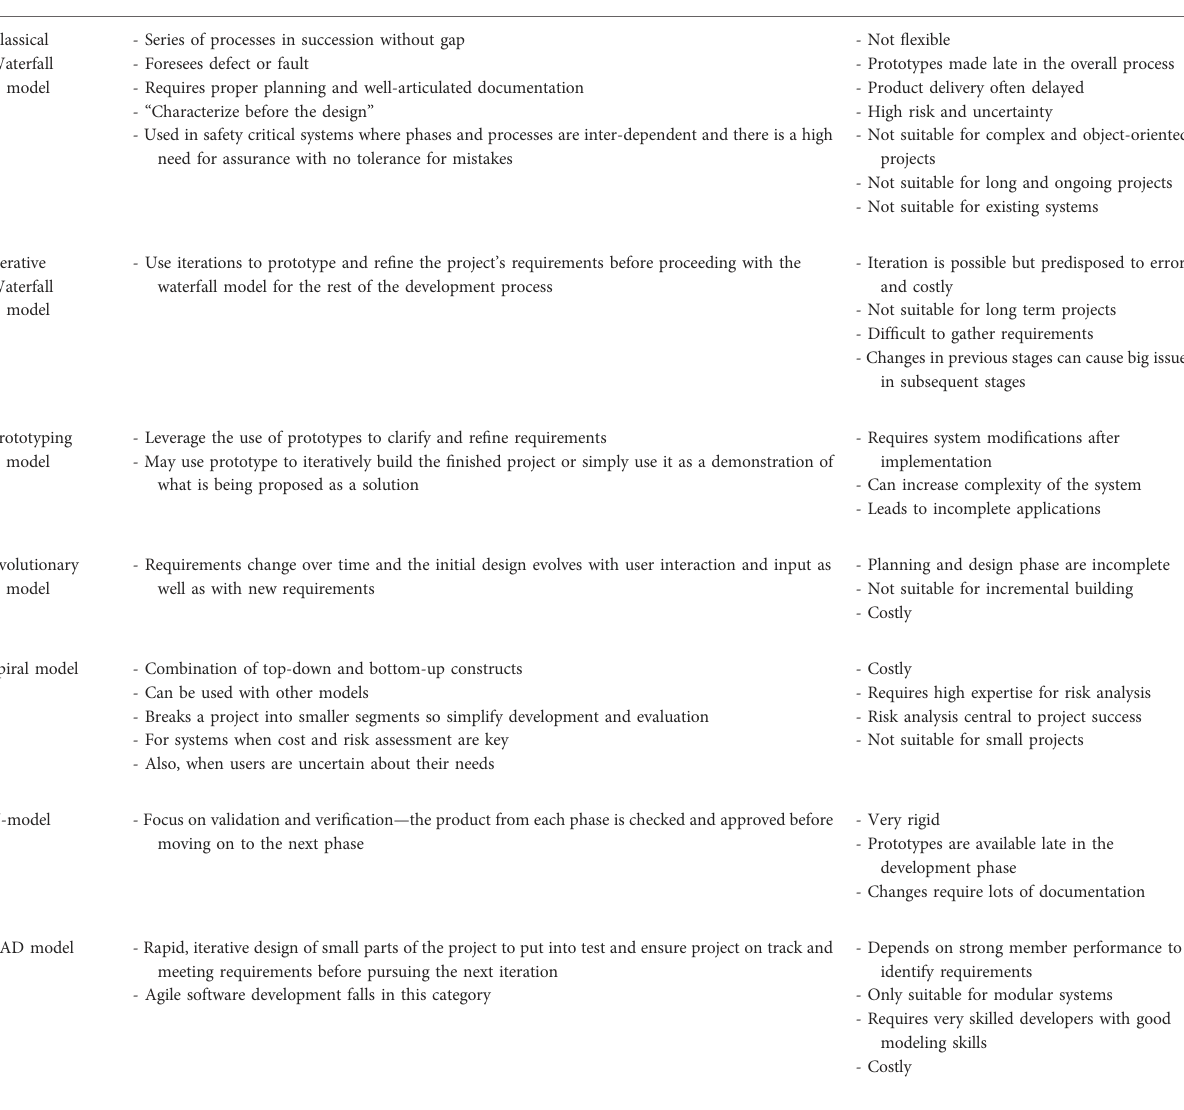
TABLE 2 Overview of current software development life cycle models and their limitations (8, 28, 29).